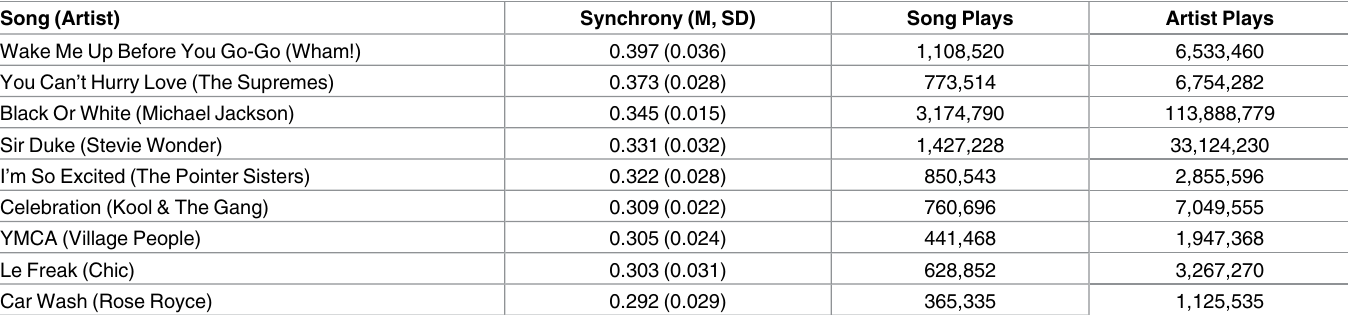
Table 1. Song synchrony and music popularity.